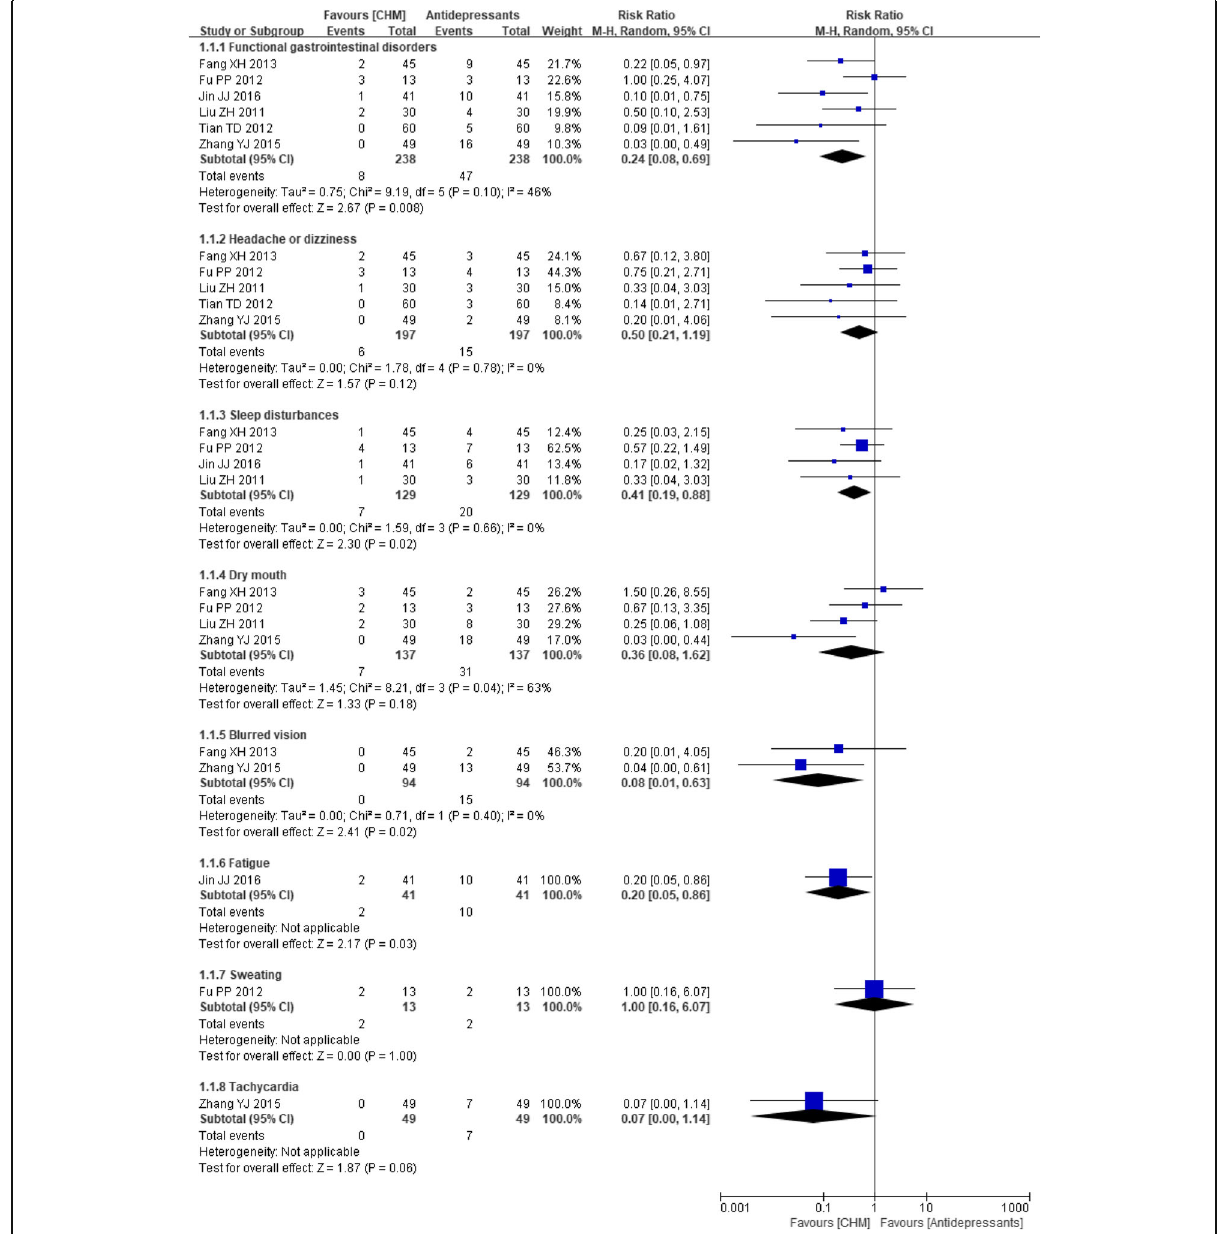
Fig. 15 Forest plot of adverse events for CHM versus